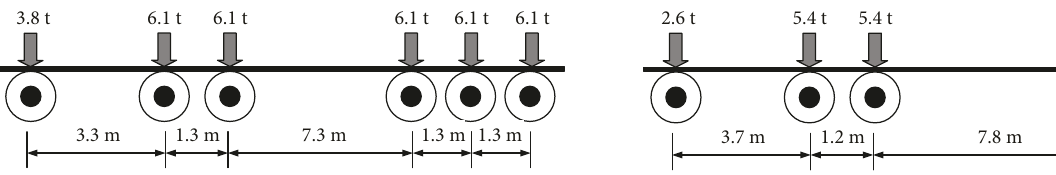
Figure 10: Suggested fatigue truck model. Figure 11: Standard fatigue truck model of AASHTO